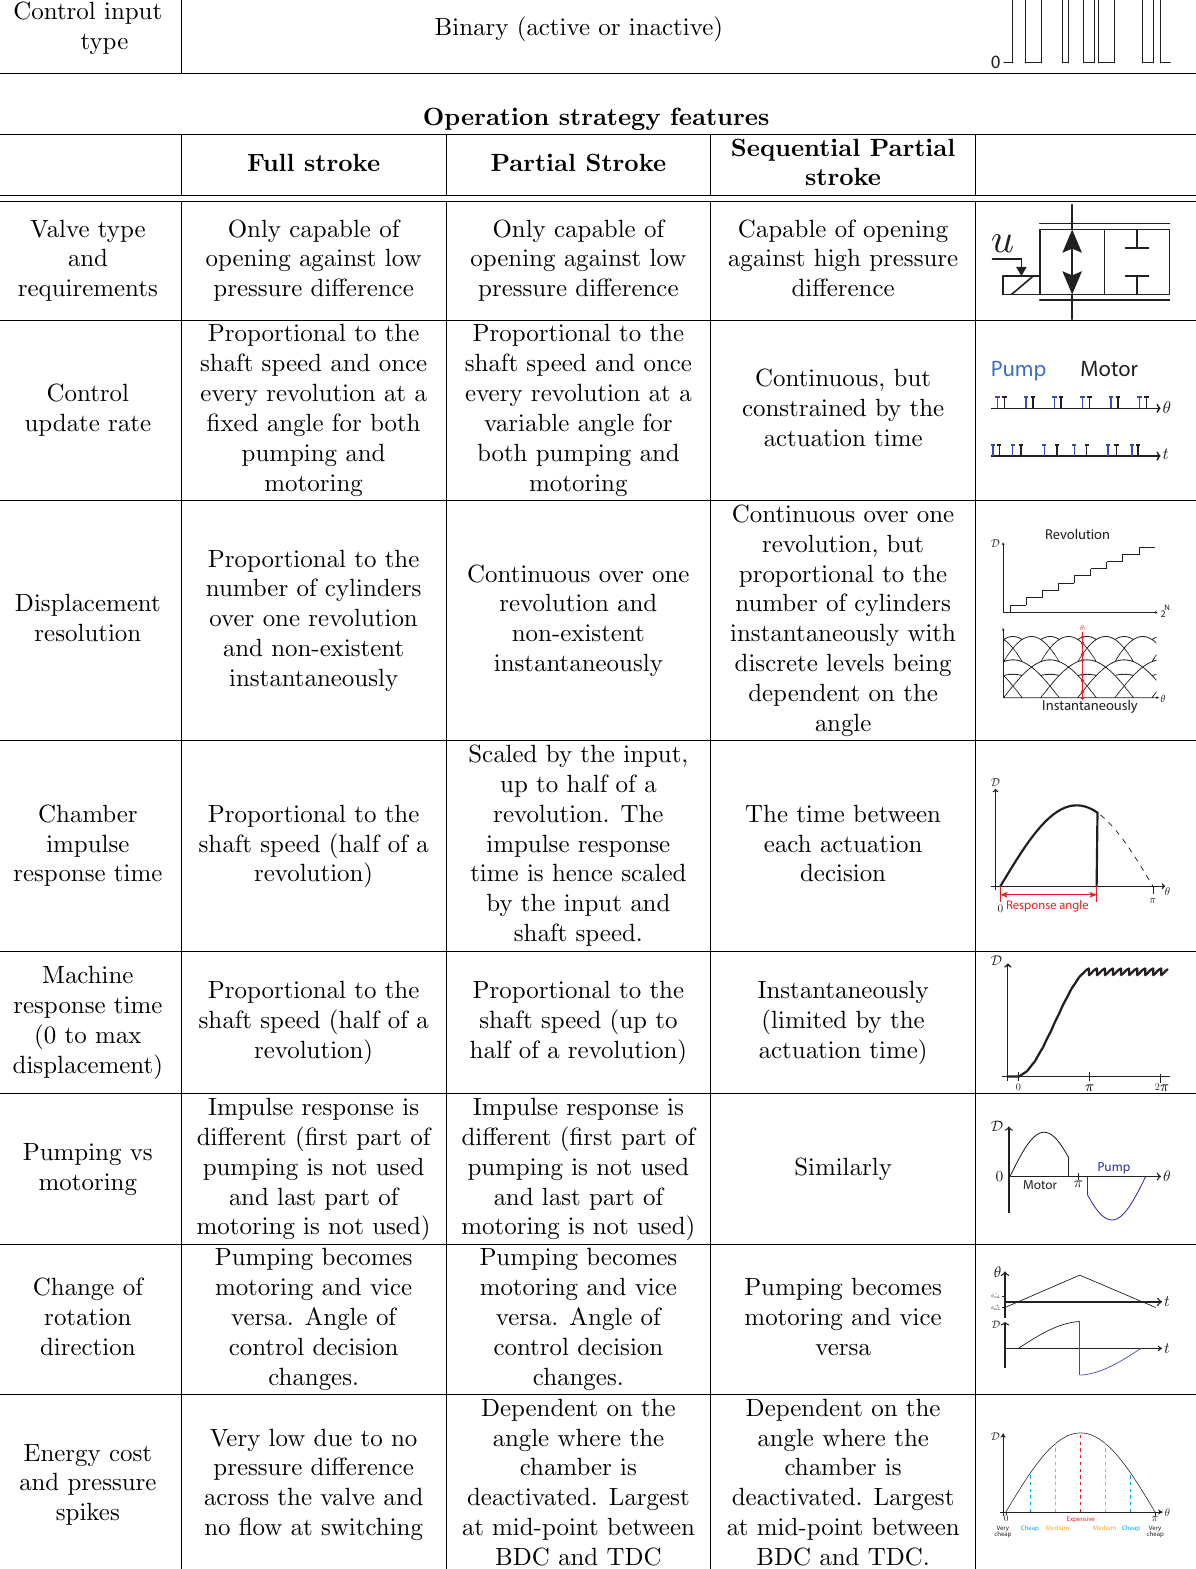
Table 1: Summarization of the dynamical behavior and control challenges of digital displacement units.